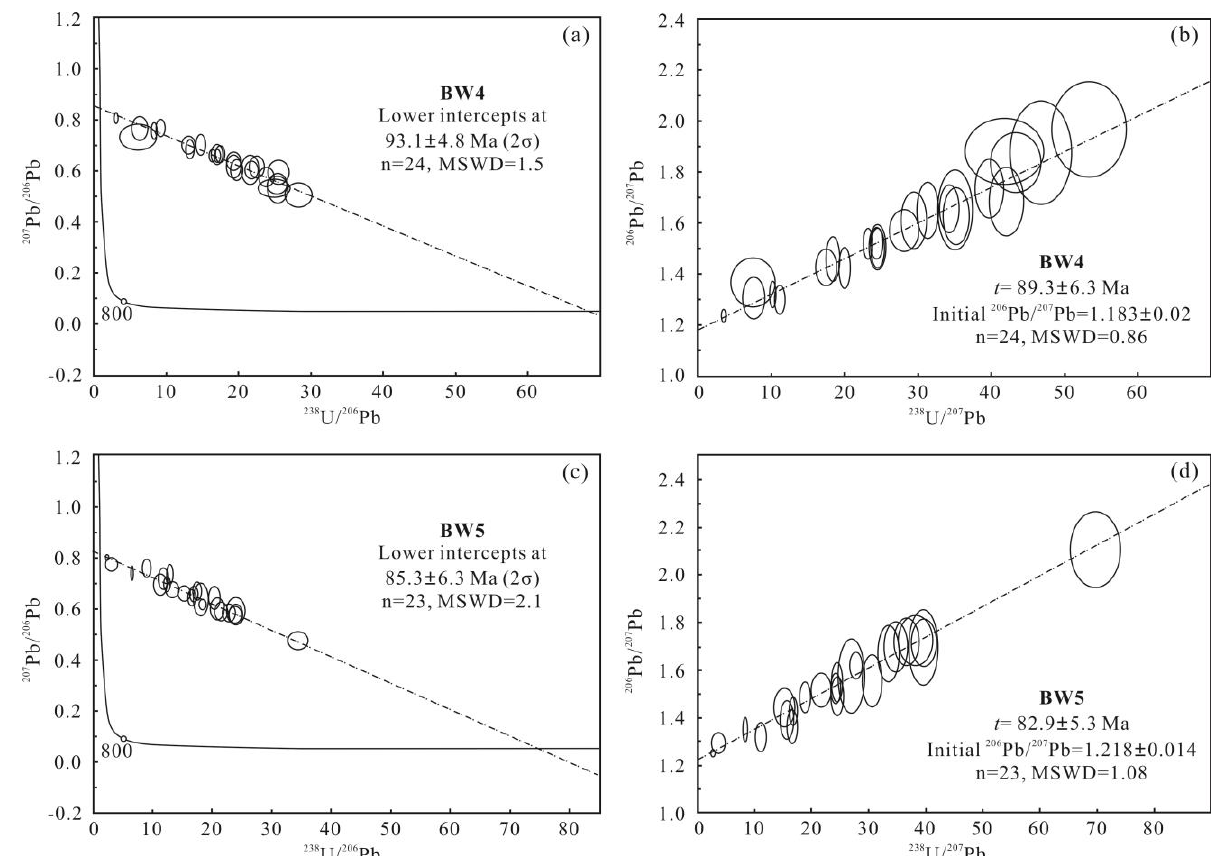
Figure 6. U–Pb concordia diagrams (Tera–Wasserburg) and isochron diagrams of cassiterites from the Bawang deposit. ( a ): concordant age of BW4, ( b ): isochron age of BW4, ( c ): concordant age of BW5, ( d ): isochron age of BW5.